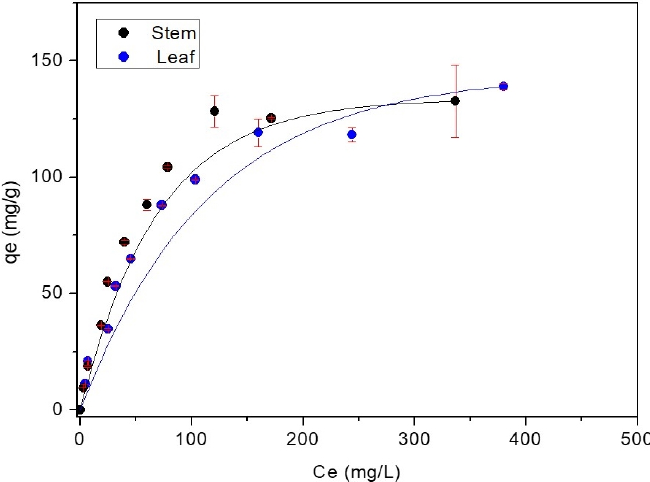
Figure 6. MB adsorption isotherm for water hyacinth stem and leaf biomass. The downward concave adsorption isotherm indicates a strongly favorable isotherm that leads to greater adsorption capacity [69]. When analyzing the adsorption isotherm in Figure 6, the plotted curves illustrate that the adsorption for both stem and water hyacinth leaf biomass is favorable, indicating that the adsorption process occurs even at low concentrations. By linearizing the obtained data, it was possible to adjust the experimental data to the Langmuir and Freundlich models for stem (Figure 7a,b) and leaf (Figure 7c,d) biosorbents. The isothermal parameters are in Table 3.